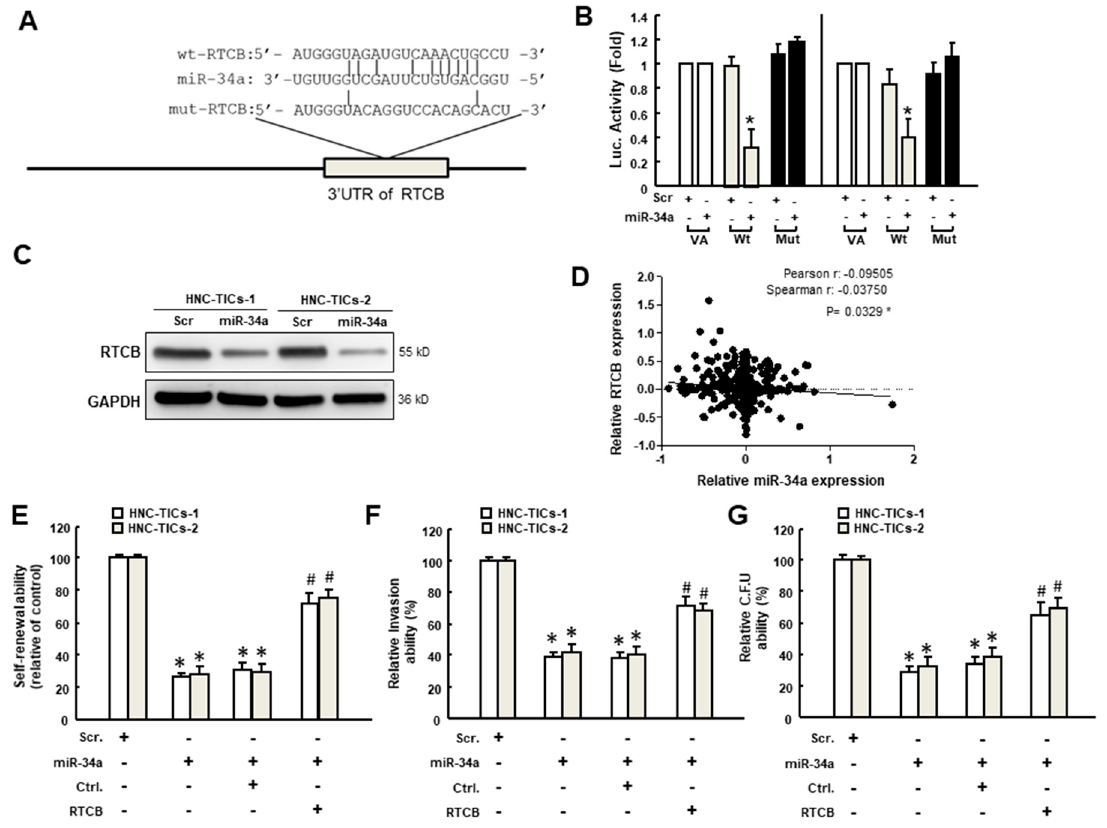
Figure 6. ( A ) Schematic presentation of the constructed 3 ′ untranslated region (UTR) reporter plasmids of RTCB (RNA 2',3'-cyclic phosphate and 5'-OH ligase). Wild-type (Wt) and mutated (Mut) RTCB reporter plasmids were co-transfected with miR-34a or empty vectors (vector alone; VA); ( B ) The luciferase activity of each combination in two HNC-TICs (tumor-initiating cells of head and neck cancers) was assessed and only WT reporter activity was suppressed by miR-34a; ( C ) The expression of RTCB in HNC-TICs with scramble or miR-34a overexpression; GAPDH (glyceraldehyde-3-phosphate dehydrogenase) was used as the internal control. ( D ) The inverse correlation between RTCB and miR-34a in HNC samples using The Cancer Genome Atlas (TCGA) dataset; ( E ) Self-renewal ( F ), invasion or ( G ) colony-forming abilities in miR-34a-overexpressing cells with or without RTCB overexpression were evaluated. * p < 0.05 compared to scramble control. # p < 0.05 compared to miR-34a overexpression group.